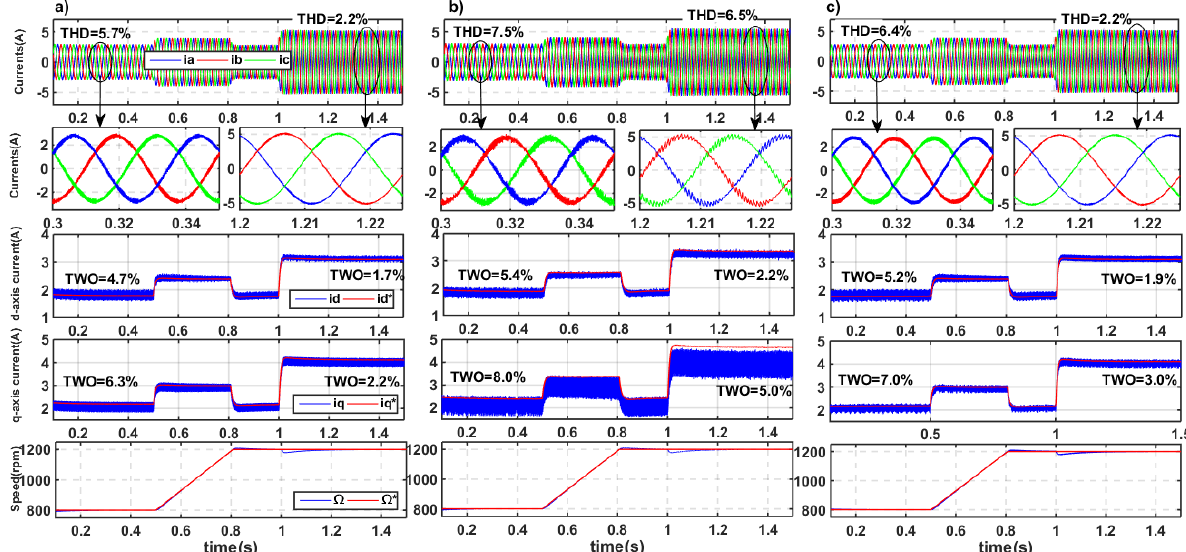
Figure 5. Simulation Results under speed and load variation. ( a ) MBPCC with nominal parameters, ( b ) MBPCC under the influence of parameter variations (0.5xLd, 0.5xLq), ( c ) proposed GW − MFPCC. Electronics 2023 , 11 , 4166 Figure 6 shows the three phase currents, d ‐ axis current, q ‐ axis current, and the rotor speed at 1100 rpm, under a load torque of 5 Nm. The results of MBPCC with optimal parameters are seen in Figure 6a. Since the MBPCC is highly dependent on the SynRM parameters that may vary due to the magnetic saturation effect and operating condition, optimal parameters can be inaccurate. The MBPCC performance under inaccurate parameters is shown in Figure 6b. Since inductance uncertainty has a greater impact on control performance than resistance uncertainty, the dq ‐ axes inductances are set lower than their optimal values in the MBPCC algorithm. The experimental results of the proposed GW ‐ MFPCC are seen in Figure 6c, where the system model and parameters are totally eliminated.